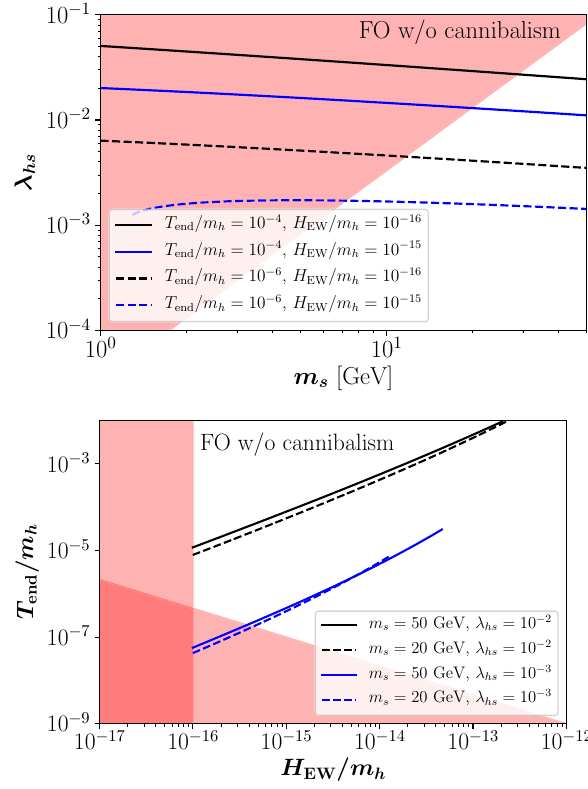
Fig. 1 DM freeze-out without cannibalism. Parameter space giving rise to the observed DM relic abundance. The red regions correspond to the constraints discussed in Sect. 2.2. Other observational constraints are discussed in Sect. 4 and shown in Fig. 8